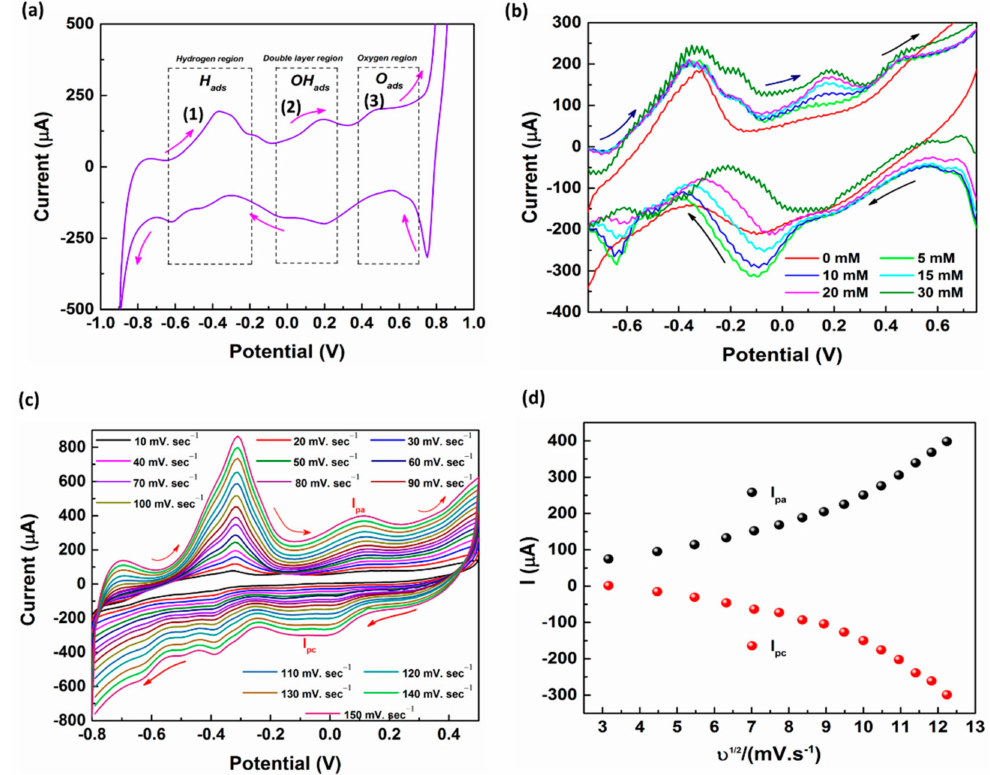
Figure 4. CV of the Au/Pt-black/Nf MN in 10 × PBS (pH = 7.4) with 5 mM glucose addition at a scan rate of 50 mV · s − 1 in 10 × PBS (pH = 7.4) ( a ), CV of the Au/Pt-black/Nf MN in 10 × PBS (pH = 7.4) with increasing concentrations of glucose between 0 and 30 mM at a sweep rate of 50 mV · s − 1 ( b ). CVs of Au/Pt-black/Nf MNEA at various scan rates ranging from 10 → 150 mV s − 1 in 10 × PBS, pH 7.4 containing 5 mM of glucose ( c ), the relationship between the square root of scan rate vs. Ipa ( d